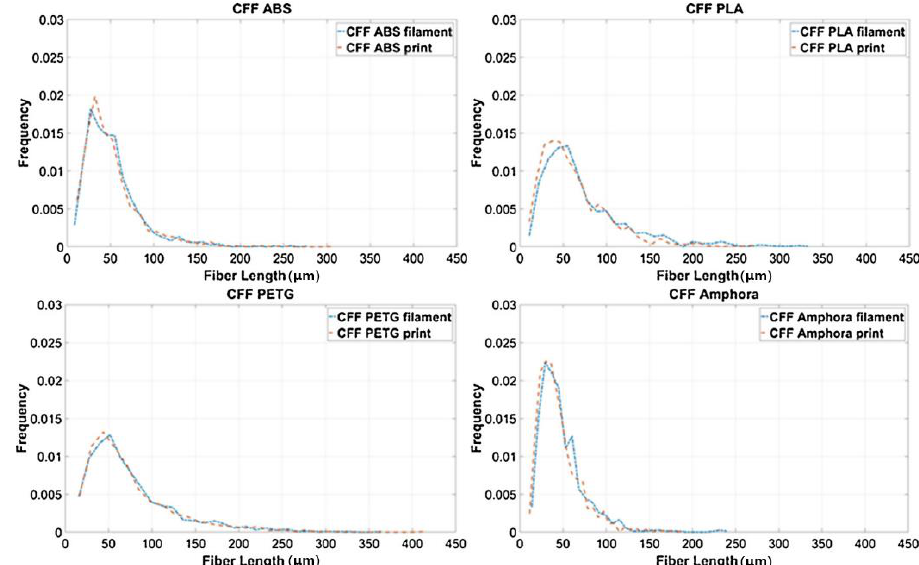
Figure 11. Fiber length distributions plots for each CFF material filament [126].